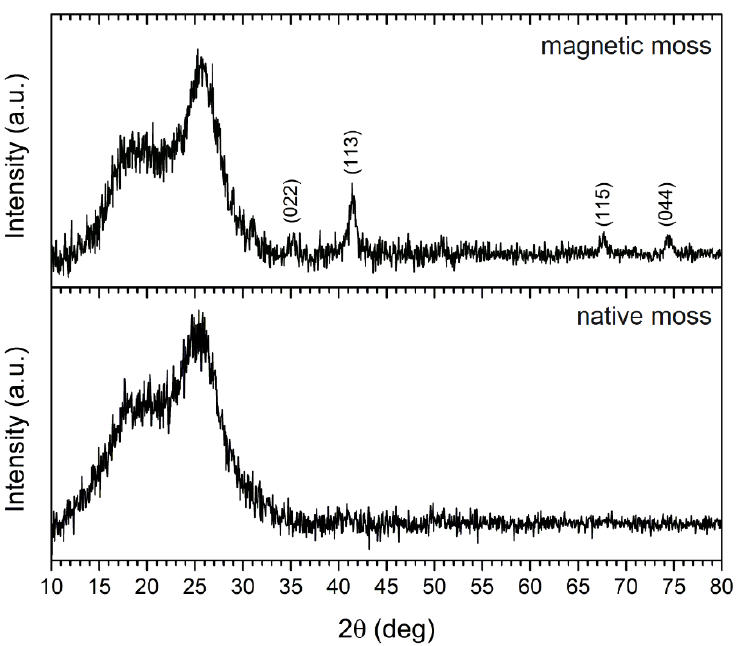
Figure 3. XRD pattern of native and magnetically modified R. squarrosus recorded using Co K α 1,2 radiation.